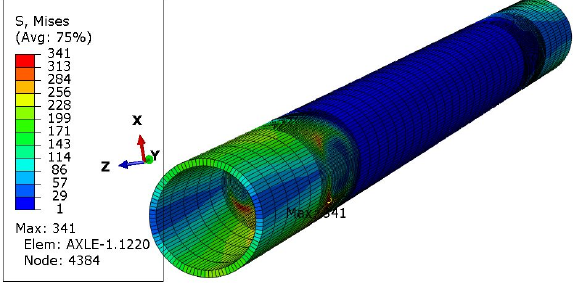
Figure 10. Stress distribution in the axle and max strengthen node 4384 while side force during turning acts to the left wheel.